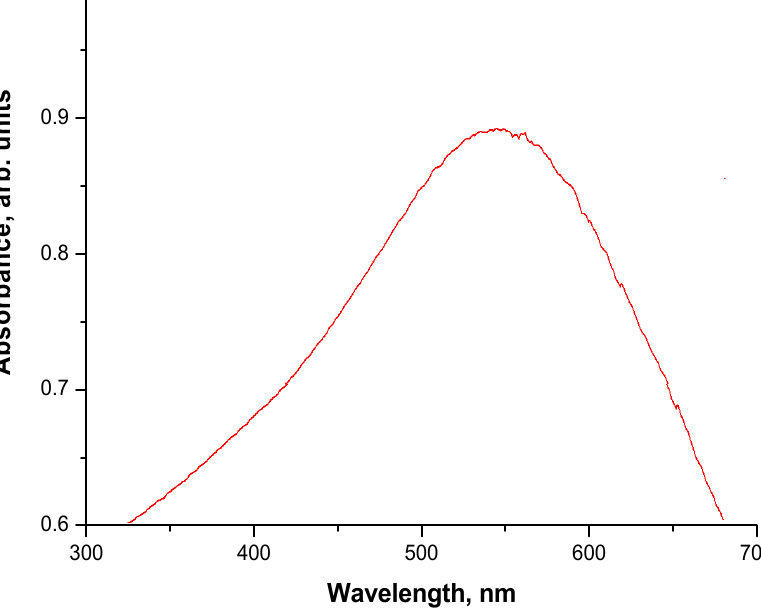
Figure 9. UV-Vis spectrum of Fe 3 O 4 @Au particles obtained in the oil and water environment. The absorption band with a maximum absorbance at a wavelength of approx.